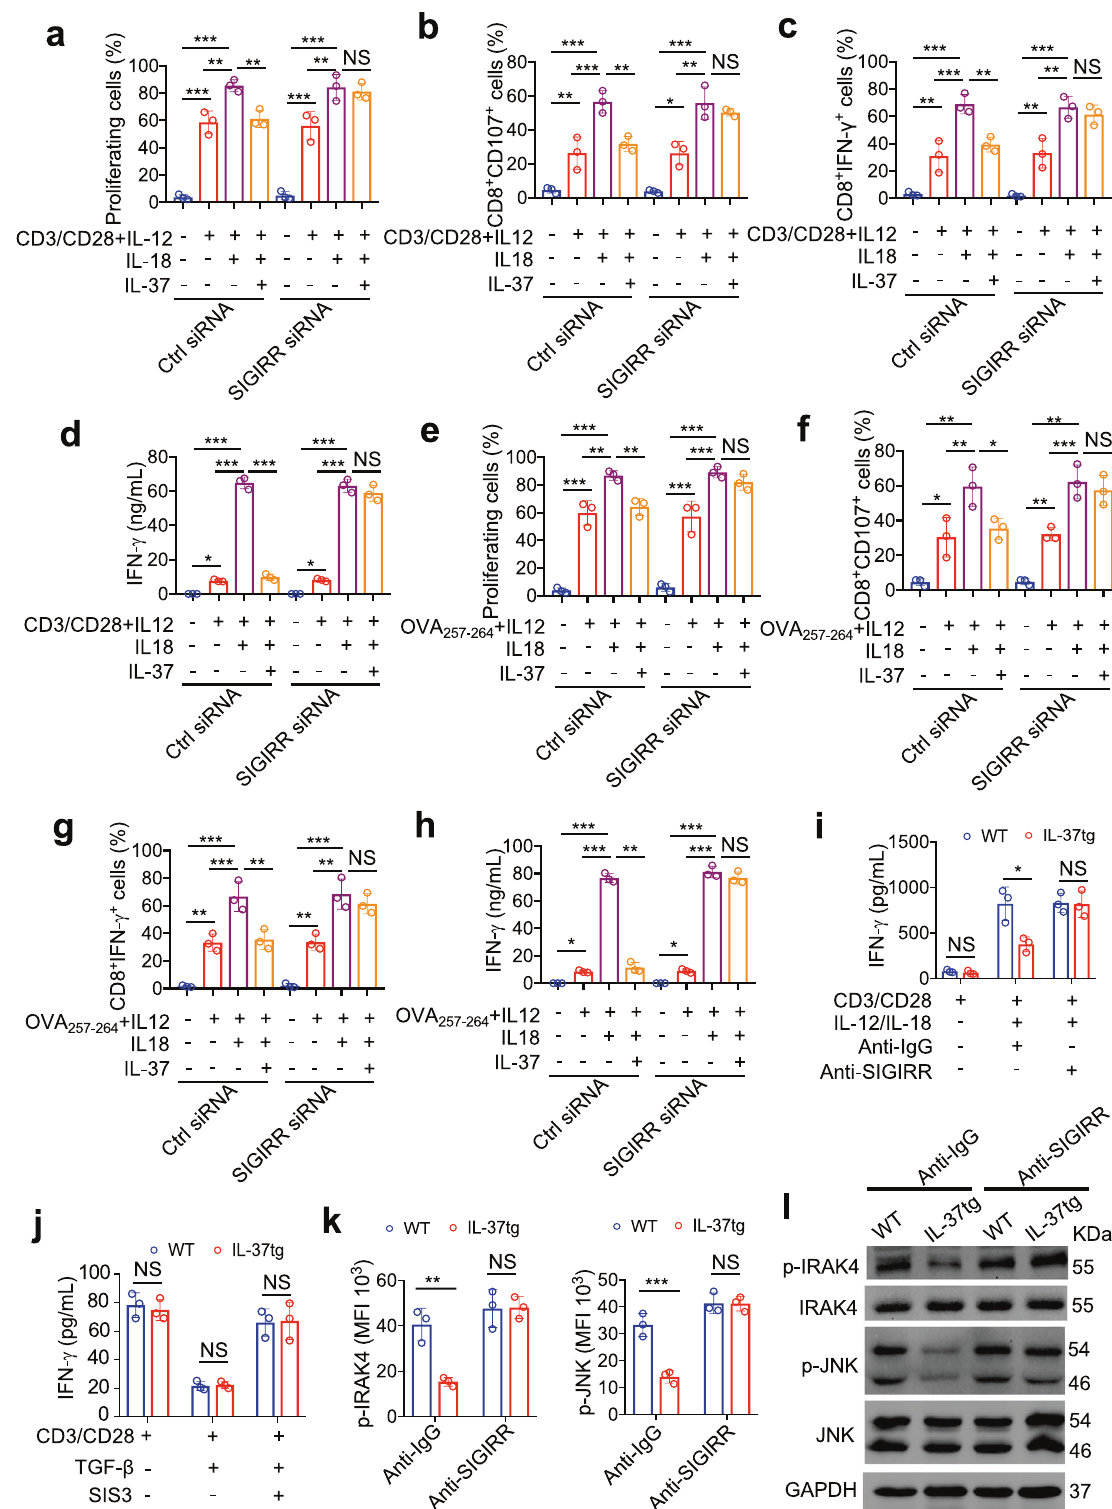
littermates on C57BL/6N background (aged 8 – 10 weeks) were intraperitoneal injection with AOM (Sigma) dissolved in 0.9% NaCl (10 mg/kg/dose). Mice were treated with 2% DSS salt (MP Biomedicals) in drinking water at 5 days after AOM injection, then regular water for 14 days, this cycle was repeated thrice.